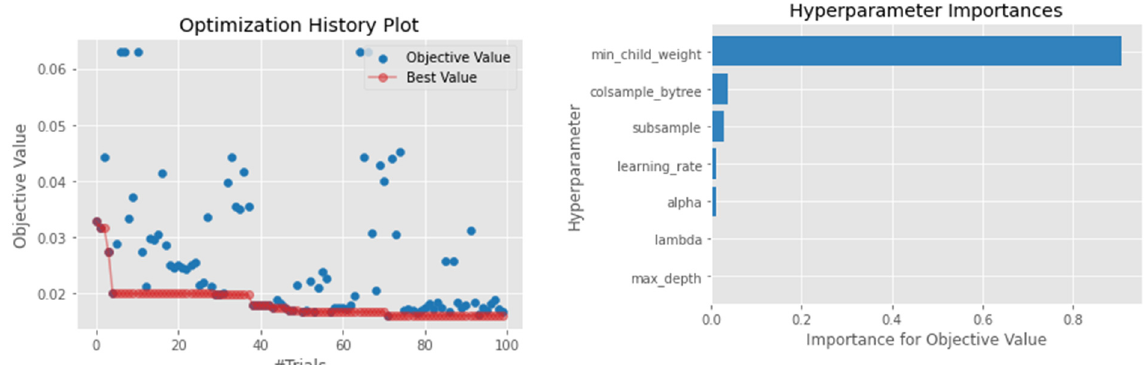
Figure 3. Hyperparameter optimization for the XGBoosting model.